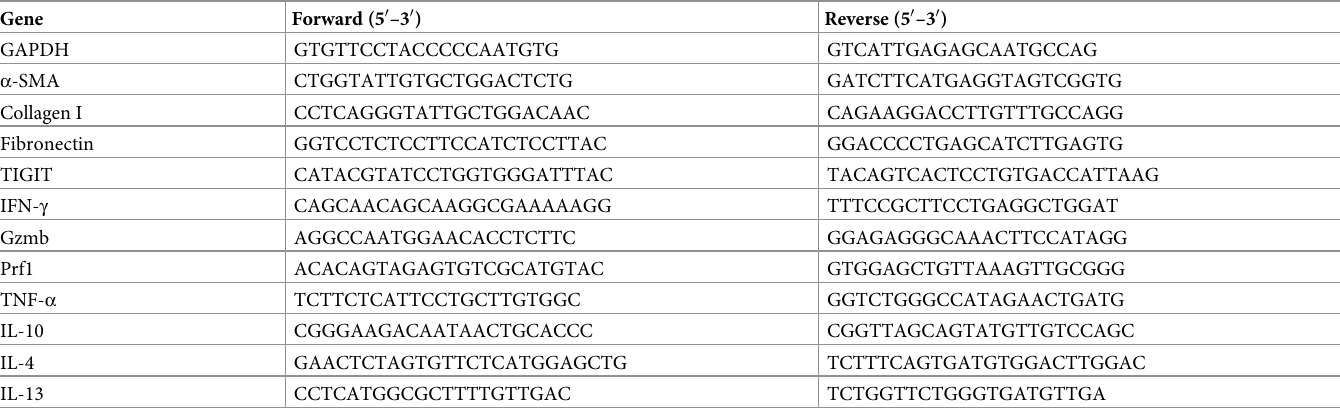
Table 1. Primer sequences for reverse transcription-quantitative